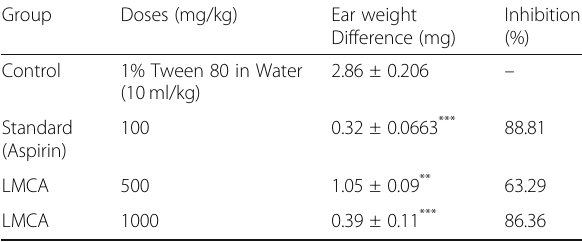
Table 6 Effect of LMCA in Xyline induced ear edema